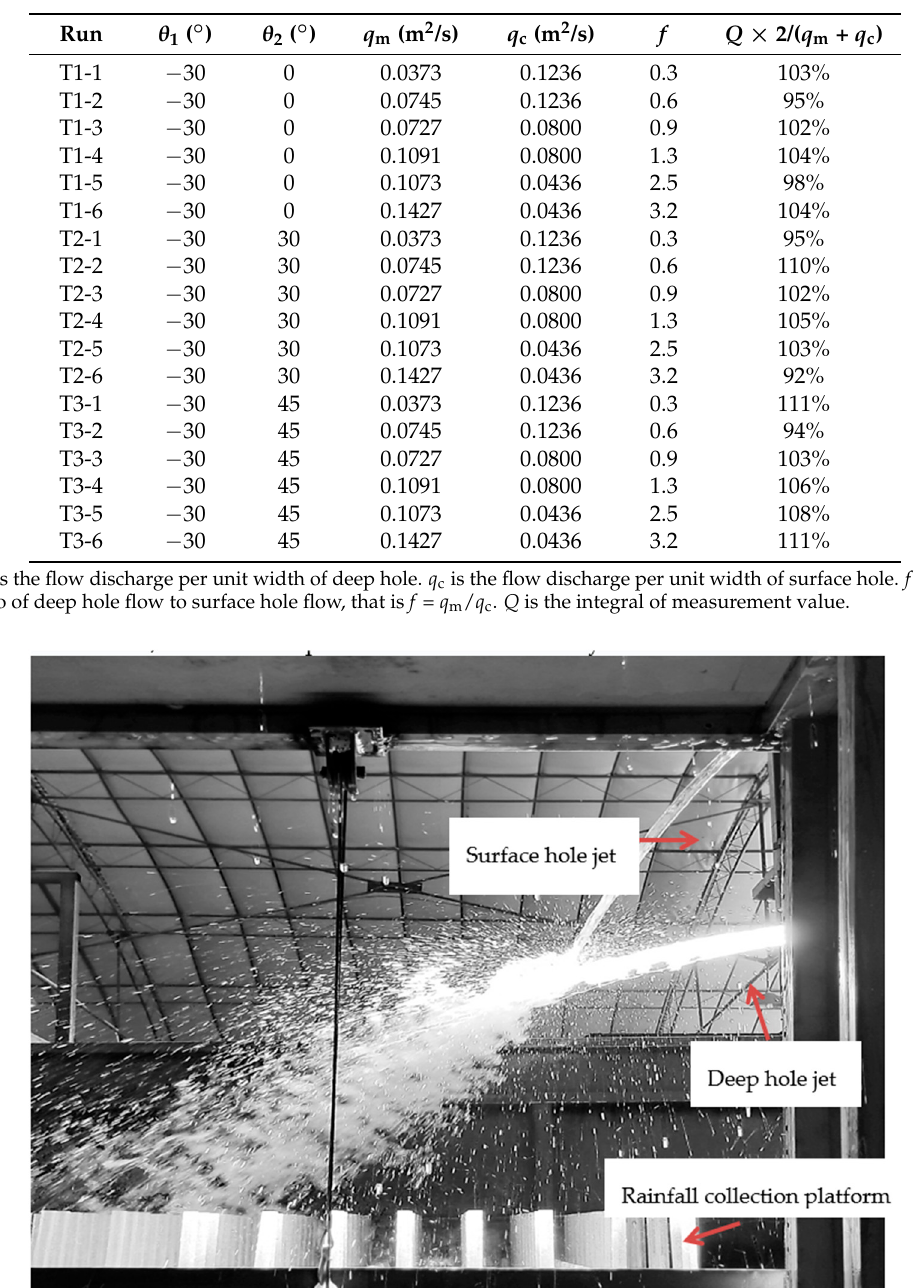
Table 1. Working conditions in experiments.